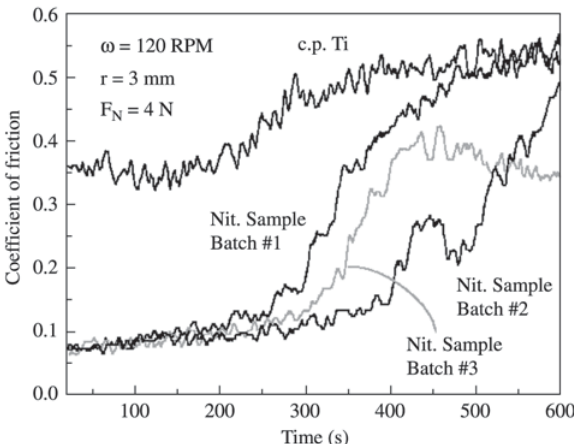
Figure 6. Coefficient of friction as a function of the sliding time for the control and nitrided